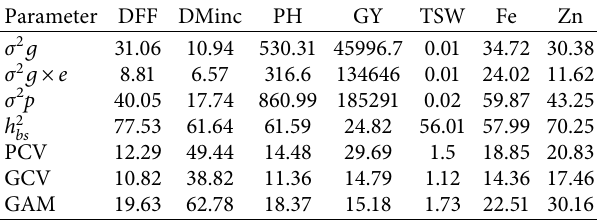
Table 5: Estimates of phenotypic, genotypic, and genoty- pe × environment variability components, broad-sense heritability, and phenotypic and genotypic coefficient of variations for grain yield and other related traits of 22 OPVs in Ghana.